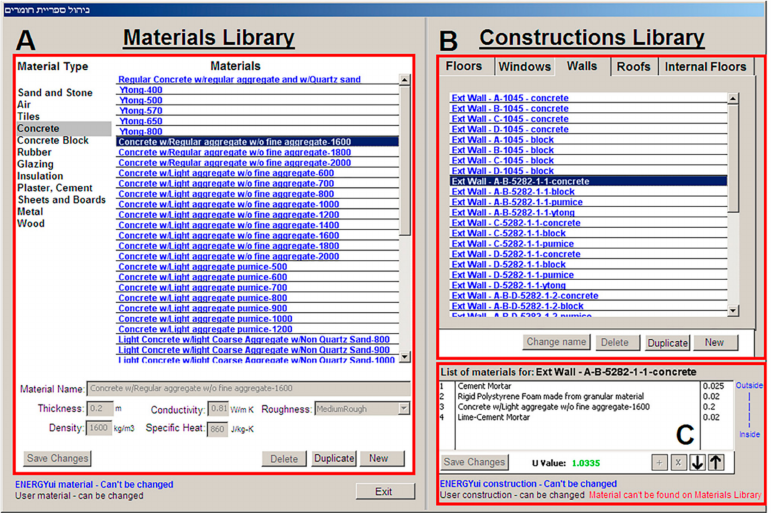
Figure 8. Material/construction library. List of materials ( left ); list of constructions ( right